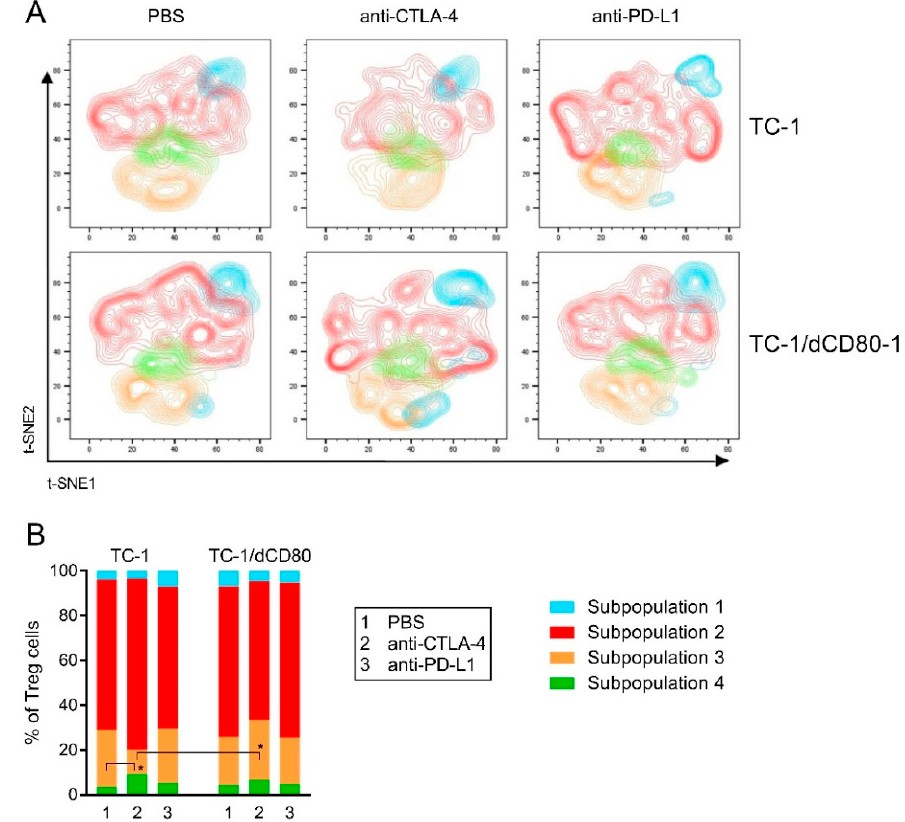
Figure 7. Diversity of Treg cells. In cells isolated from tumors ( n = 4) treated with PBS, anti-CTLA- 4, or anti-PD-L1, distinct Treg subpopulations were identified by the FlowSOM algorithm in the concatenate of all groups of samples and projected into t-distributed stochastic neighbor embedding (t-SNE) plots ( A ). The frequency of Treg subpopulations was statistically evaluated ( B ). * p < 0.05.